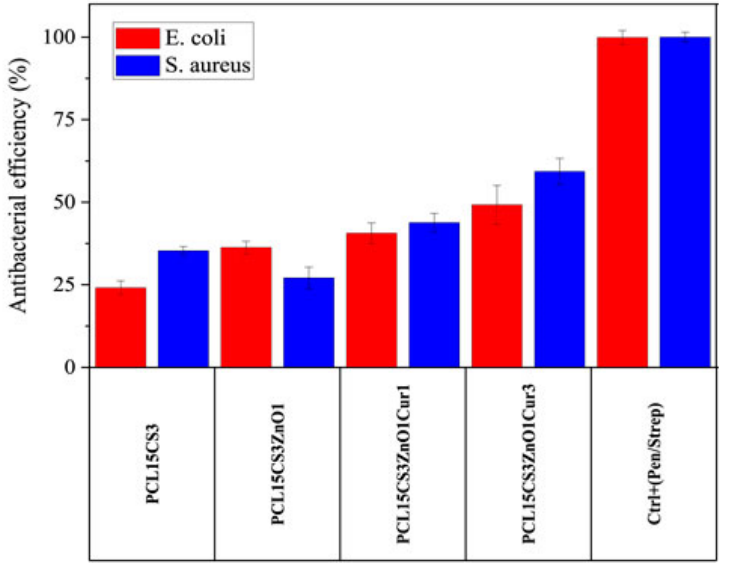
Figure 12. Antibacterial efficiency of the electrospun samples against E. coli and S. aureus bacteria after 24 h [108].